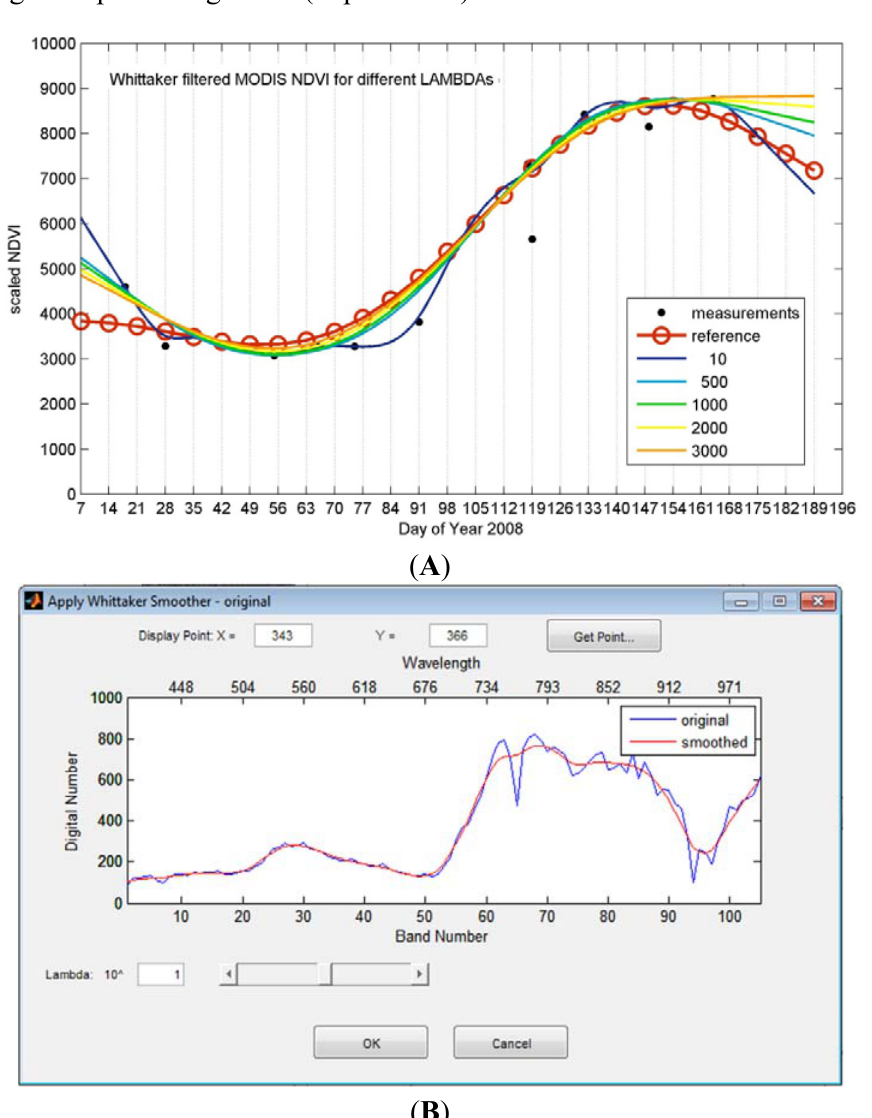
Figure 12. Illustration of the Whittaker smoother based on penalized splines. ( A ) Filtering, inter- and extrapolation of a multi-temporal NDVI profile (Moderate Resolution Imaging Spectroradiometer [MODIS]) with different settings of the smoothing parameter; ( B ) filtering of a spectral signature